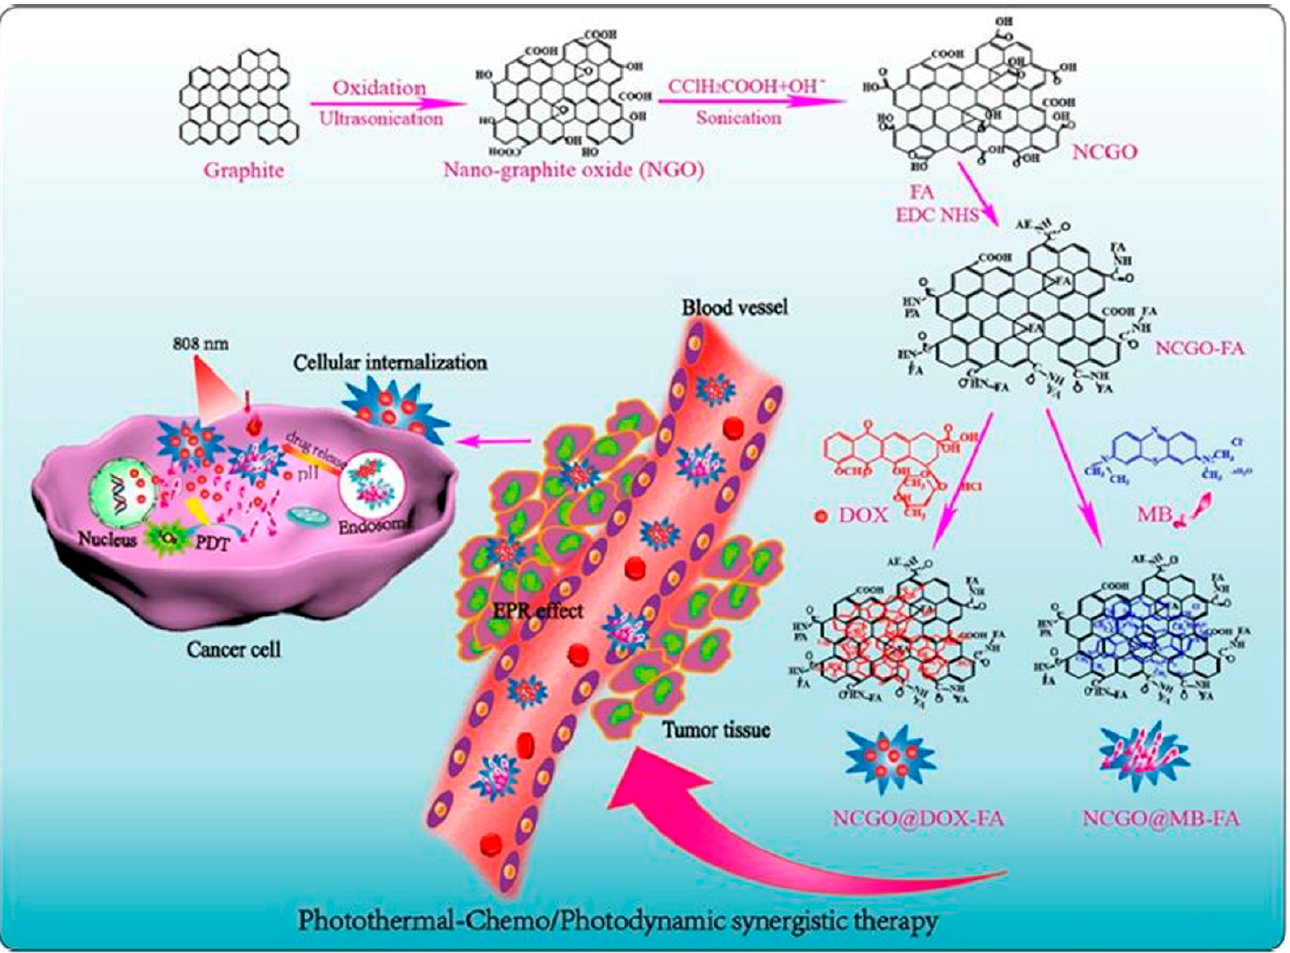
Figure 9. Performance of the versatile nano-platforms NCGO@DOX-FA and NCGO@MBFA targeted drug delivery systems for photothermal-chemo/photodynamic synergetic therapies. Folic acid: FA, and Methylene blue: MB. Reproduced with permission from [107], ACS, 2019.